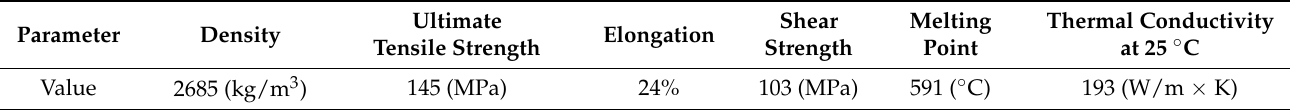
Table 1. Mechanical Properties of